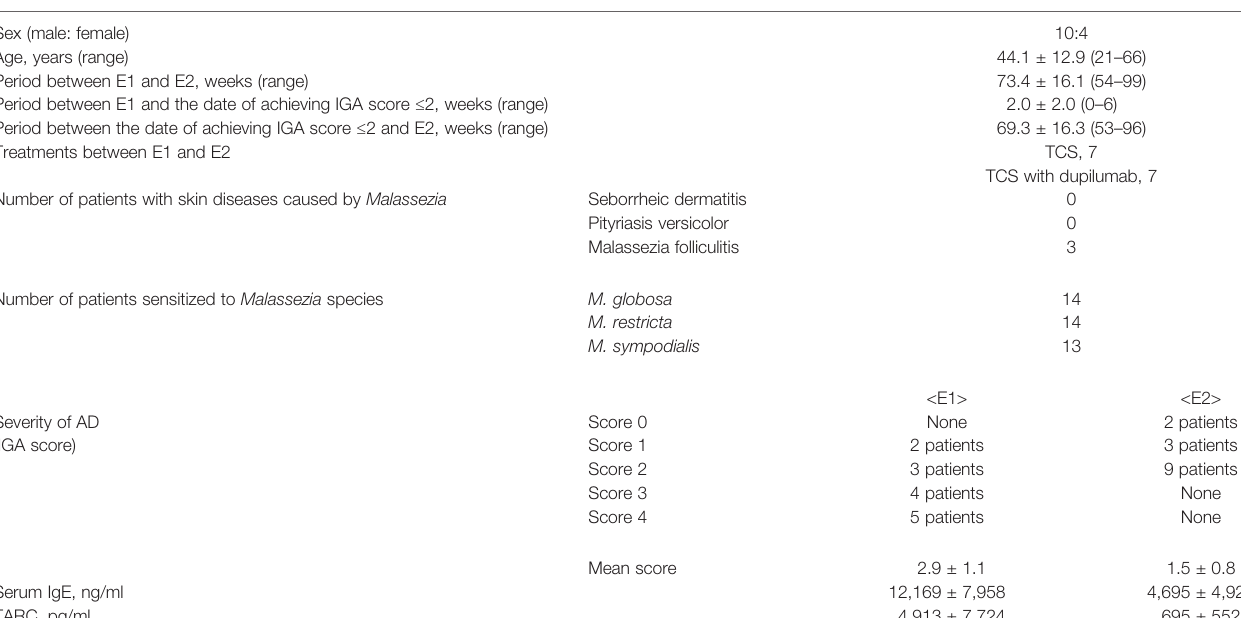
TABLE 1 | Patients ’